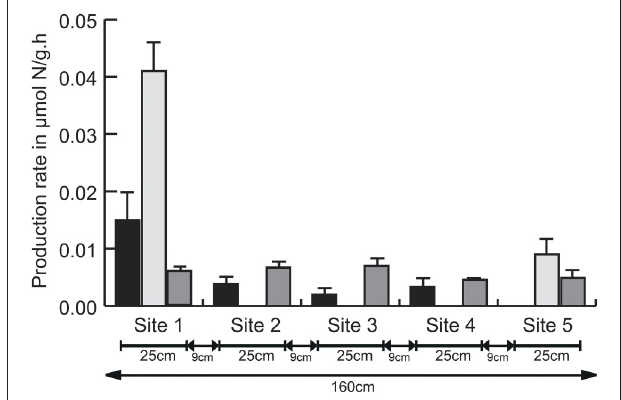
FIGURE 1 | Averaged nitrite, ammonium, and nitrous oxide production rates ( ± SD) per sampling site ( n = 3 ) over a period of 5h ( = T 1 –T 5 ). For clarity, one sided error bars are shown. Black bars: nitrate reduction to nitrite, light gray bars: dissimilatory nitrate reduction to ammonium (DNRA), dark